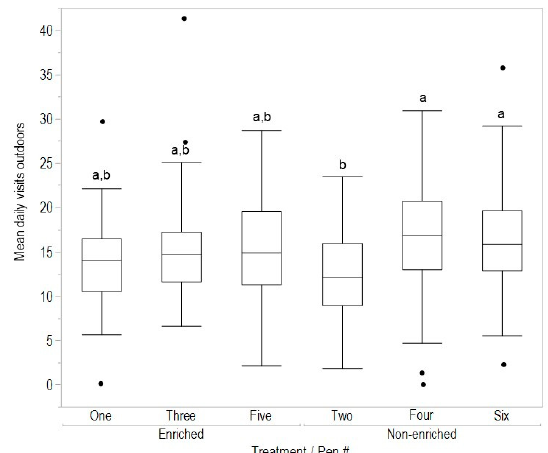
Figure 4. The mean number of daily visits outdoors by hens in each pen within the early rearing treatments (enriched, non-enriched). Data were from 36 to 38 weeks of age; dissimilar letters indicate differences between pens within treatments ( p < 0.008).